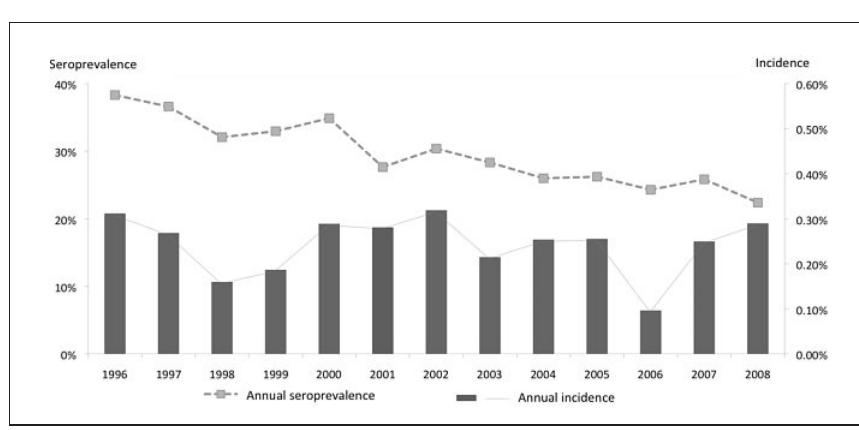
Evolution of the seroprevalence and incidence of toxoplasmosis during pregnancy (Geneva,